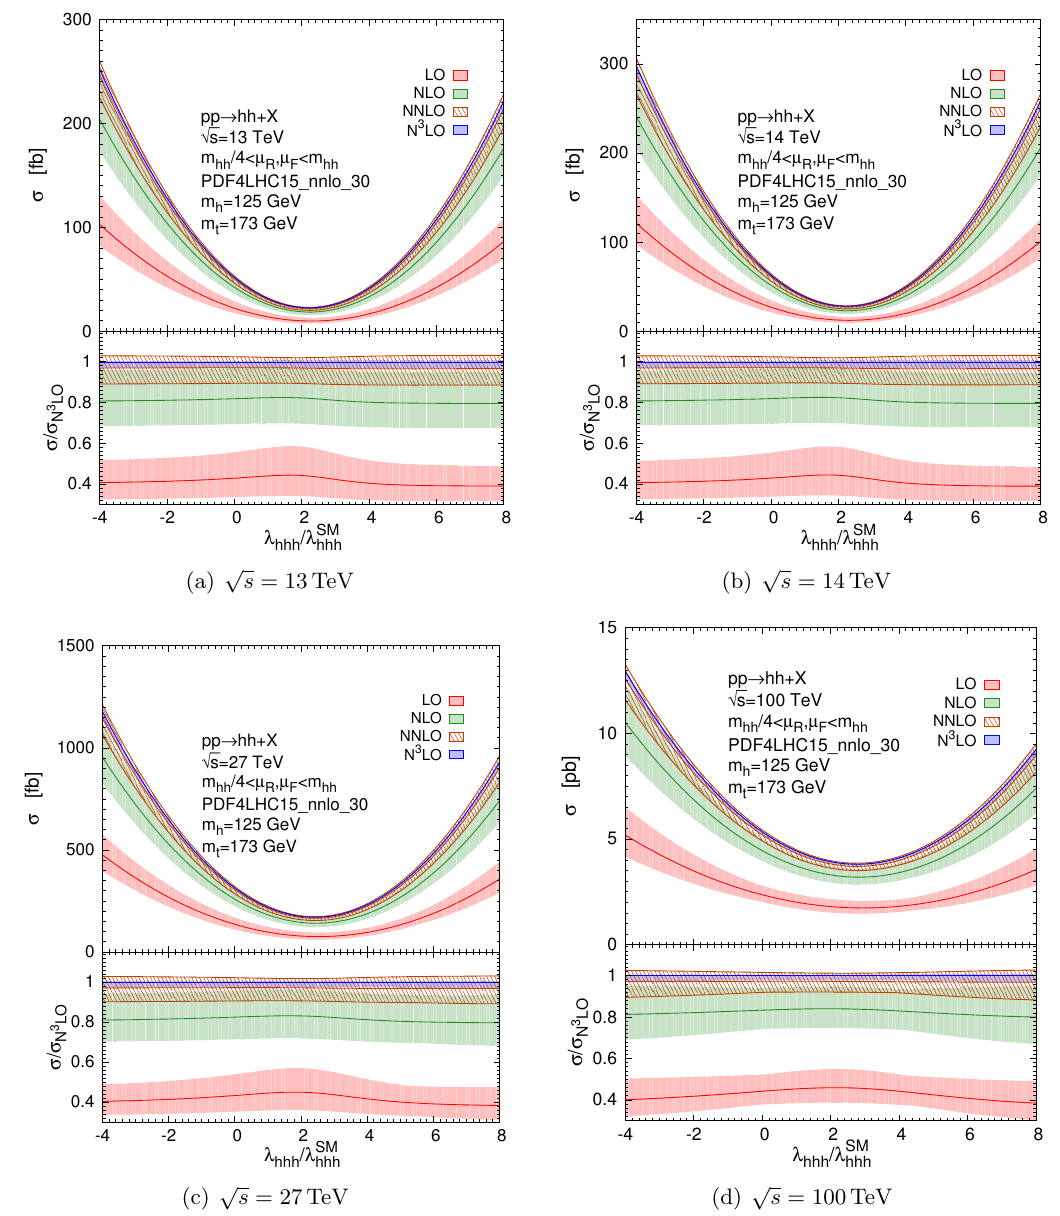
Figure 11 . The (cid:21) hhh dependencies of the total inclusive cross sections for the Higgs boson pair p production in proton-proton collisions with s = 13 ; 14 ; 27 ; 100 TeV. The bands represent the scale uncertainties. The red, green, brown and blue bands correspond to the LO, NLO, NNLO and N 3 LO predictions, respectively. The bottom panel shows the ratios to the N 3 LO distribution.